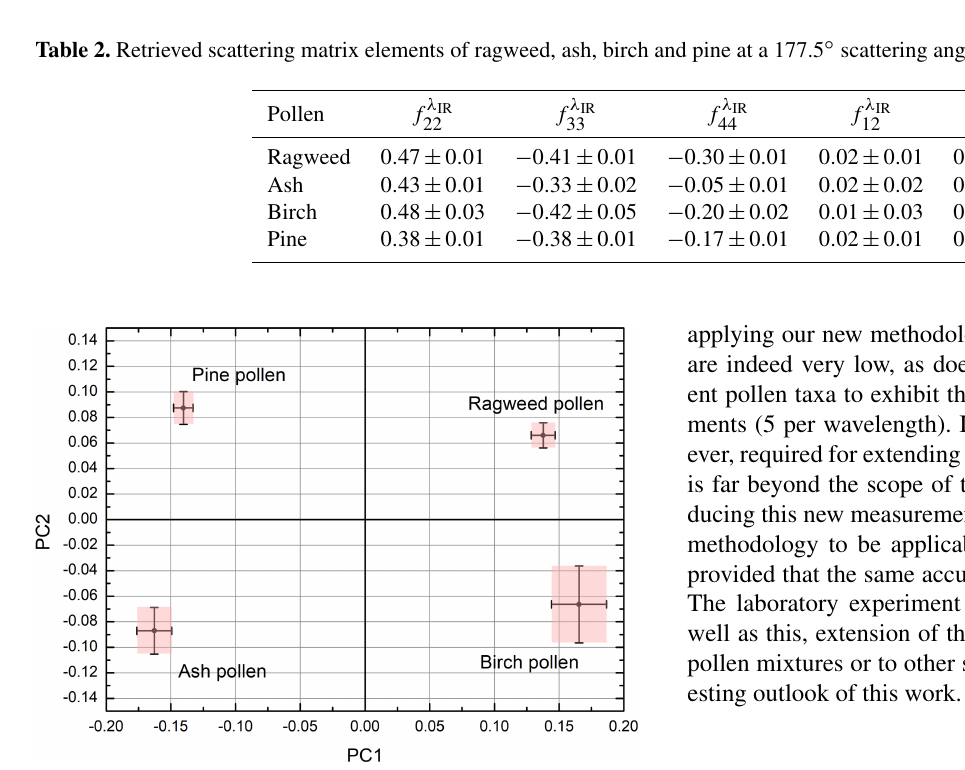
Figure 6. Projection of the 10 f ij scattering matrix elements (5 per wavelength) for each pollen taxon on the new (PC 1 , PC 2 )- orthogonal basis using principal component analysis. Error bars have been evaluated by propagating the uncertainties on each f λ scattering matrix element. Coloured regions correspond to the range of (PC 1 , PC 2 ) where the pollen taxon can be unequivocally identi- fied among our set of four pollen